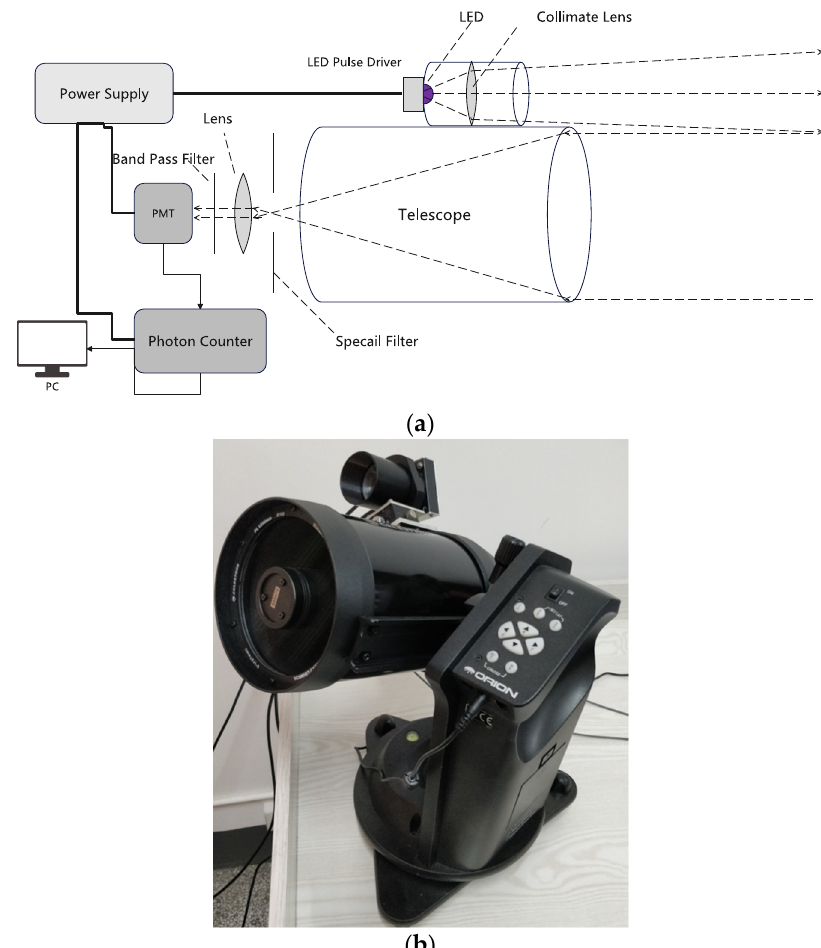
Figure 2. LED-lidar system: ( a ) schematic diagram; ( b ) prototype.